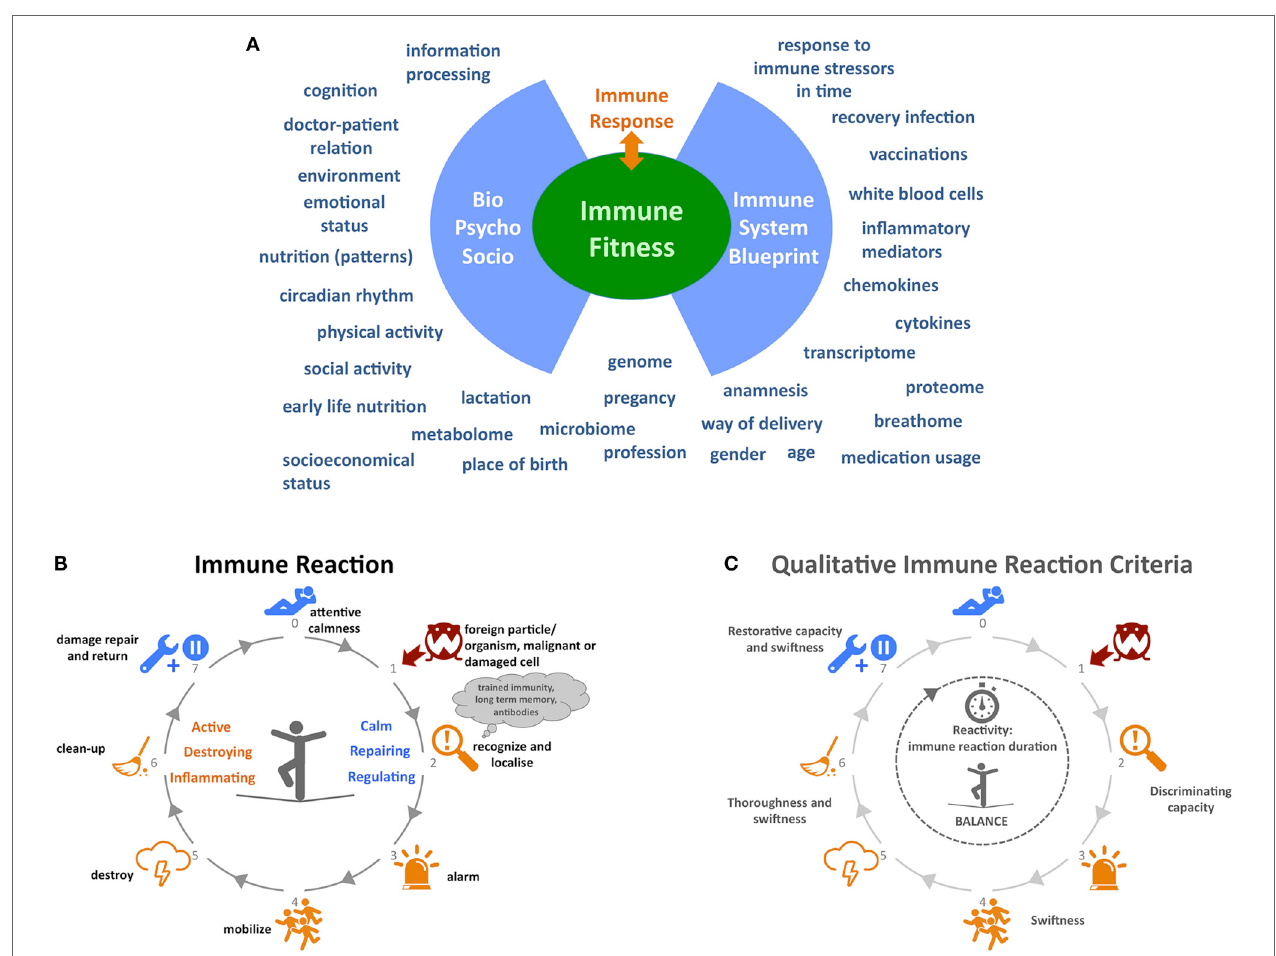
FiGUre 1 | immune functioning: embracing complexity . (A) A wide variety of determinants influencing immune function. (B) Process overview of the immune system behavior. (c) Qualitative criteria for the behavior of the immune system. At step 2 “recognize and localize” the system must be able to discriminate between true threats and harmless organisms or cells. The discriminating capacity of the system might be low in disorders like allergies, some autoimmune diseases, and immunodeficiencies. Between steps 3 and 5, the swiftness or speed of alarming, mobilizing, and destroying is key for the immune system’s effectiveness in combatting pathogens before they start growing or mutating. The same applies to the thoroughness of destroying and cleaning up pathogens in steps 5 and 6 so that no or very little strain on the body remains after the infection. The capacity to restore any damage after the infection at step 7 and the speed at which the system returns to an attemptive calmness is an often forgotten aspect of the immune system’s capabilities. In autoimmune diseases, this might be disrupted. In conclusion, the whole duration of the immune reaction to a certain pathogen can also be an indicator for (un)healthy behavior. Icons in panels (B,c) made by Katarina Stefanikova (lightning cloud) and Freepik (other icons) are from